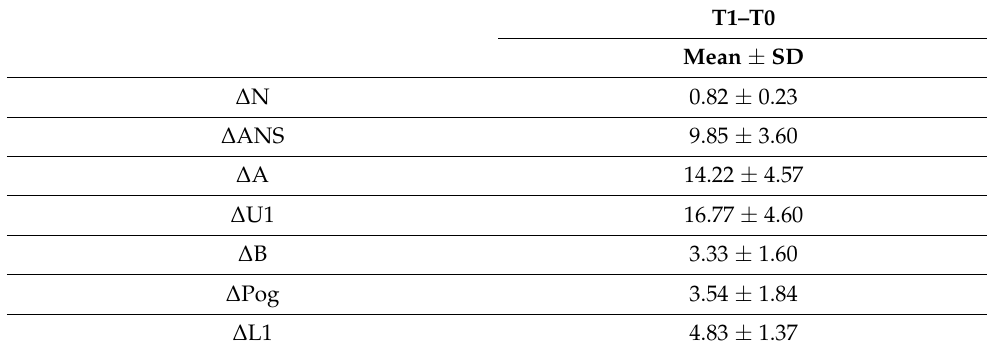
Table 6. Changes in the 3D Distance of Seven Landmarks between Pre-Treatment and Post-Treatment.